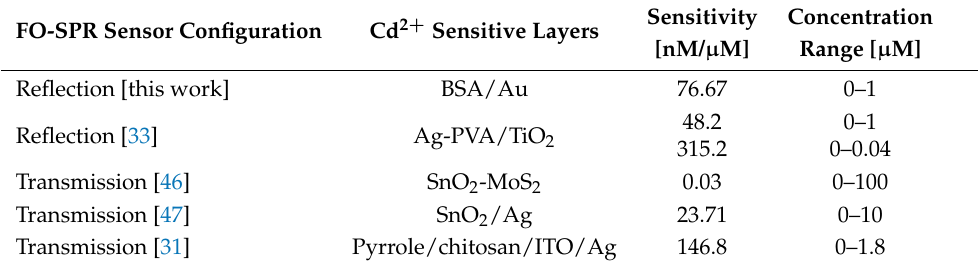
Table 2. Performance comparison of different FO-SPR sensors functionalized with layers sensitive to Cd 2 +